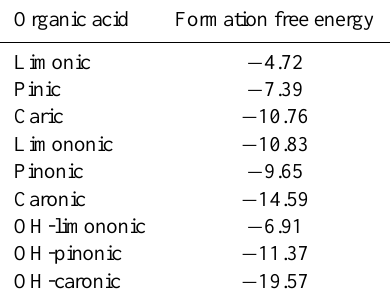
Table 6. Free energy (kcal mol − 1 ) for the addition of the second organic acid molecules onto clusters containing 1–2 sulphuric acid and organic acid molecules.